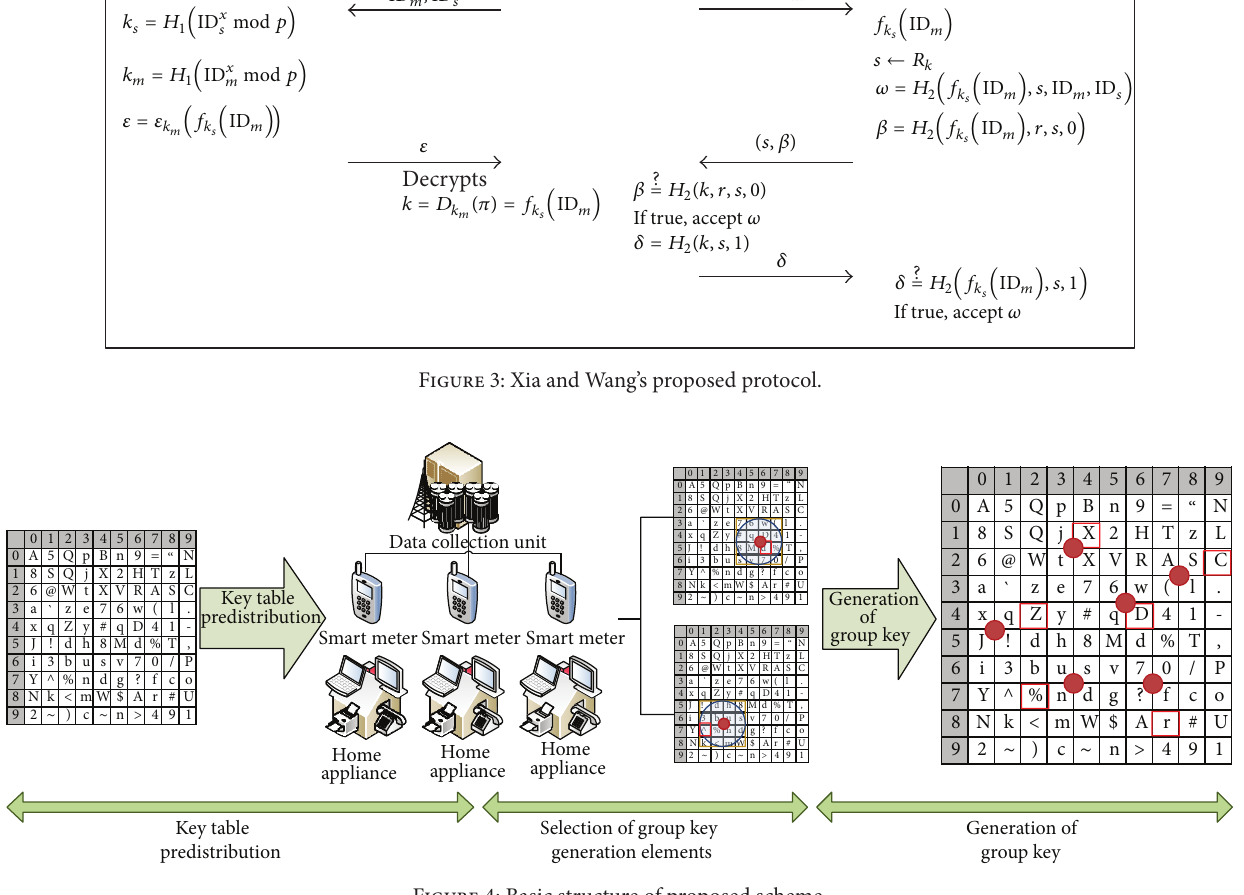
Generation of group key